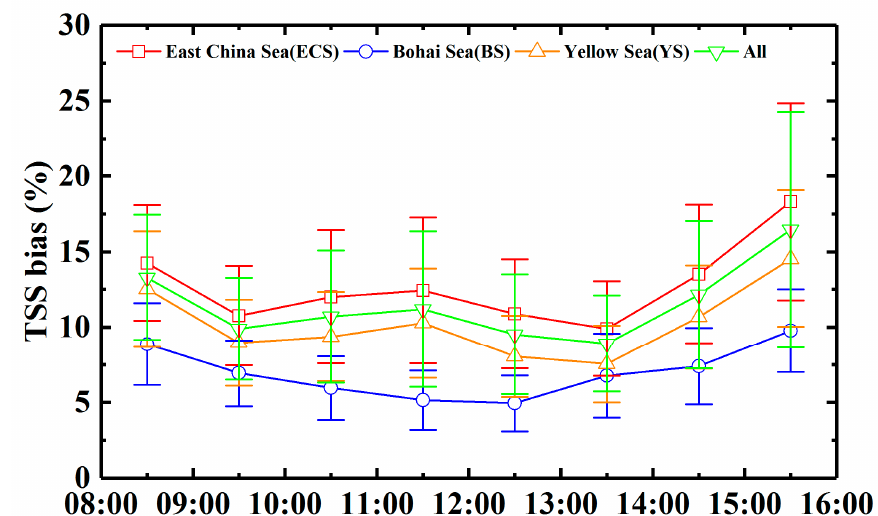
Figure 5. Temporal trends of hourly TSS bias of Chinese seas from GOCI observations.